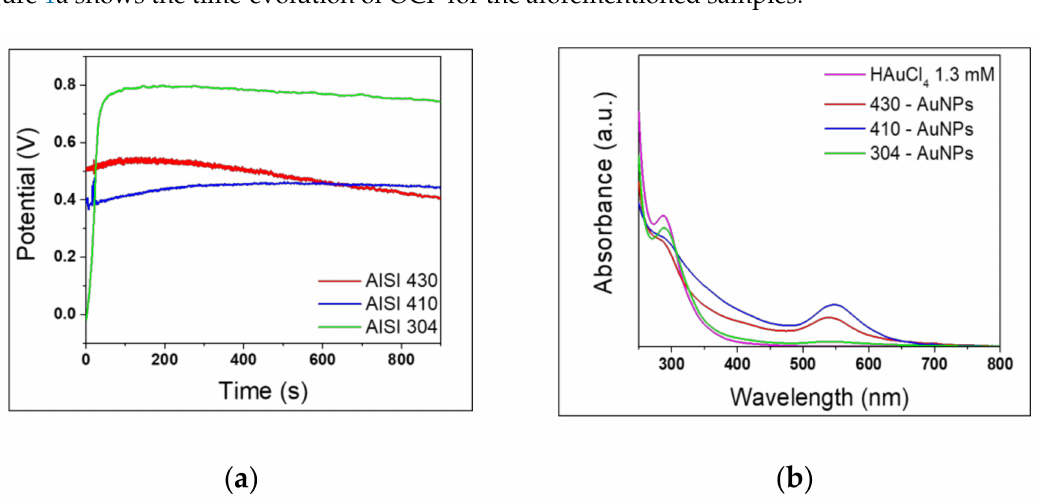
Figure 1. ( a ) OCP evolution during AuNP synthesis with di ff erent stainless steels: AISI 430, AISI 410 and AISI 304. ( b ) UV-Vis absorption spectra of the as-prepared AuNPs after 15 min of synthesis compared with the gold precursor UV-Vis